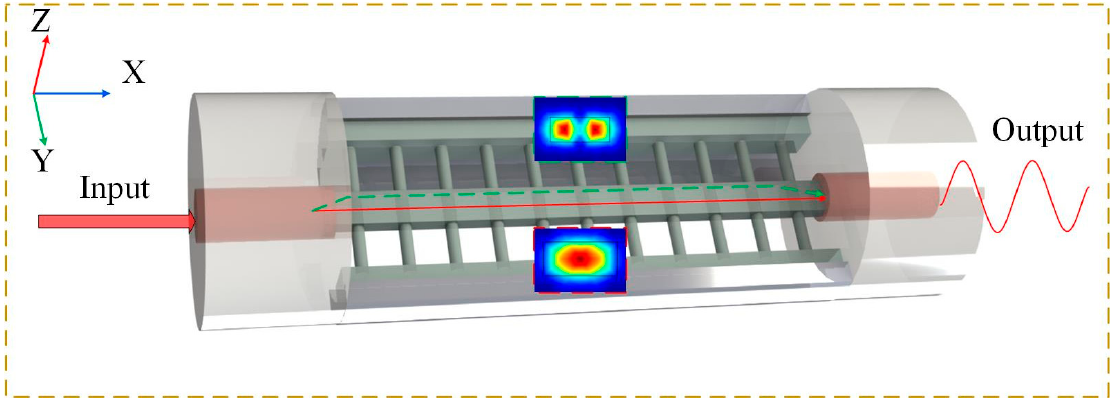
Figure 2. Schematic diagram of the polymer optical fiber interferometer (POFI) microprinted by femtosecond (Fs) laser in a silica hollow core fiber and two fiber modes created interference in the right-TCF .